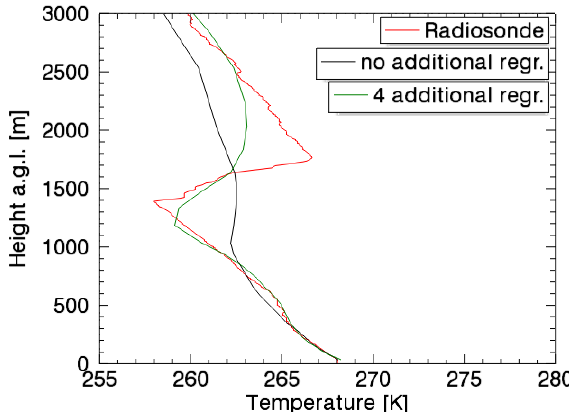
Figure 10. The effect of additional regressors for a real case that refers to 14 February 2013 at 03:18UTC (launch time of the ra- diosonde). The comparison is between the radiosonde profile, a re- trieval based only on the brightness temperatures (called “no addi- tional regr.”, corresponding to the IMGI algorithm) and a retrieval with the temperature at several heights (400, 800, 1200, 1600m) as further regressors (called “4 additional regr.”). The height is above